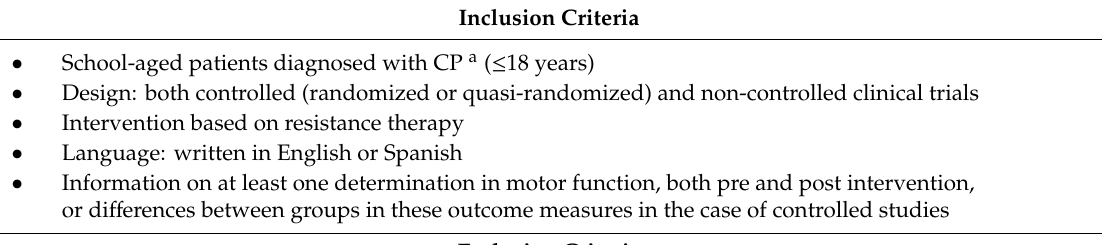
Figure 1. Flowchart used for the identification of clinical trials and studies with intervention based on resistance therapy and motor function measured as the outcome variable. Table 1. Inclusion and exclusion